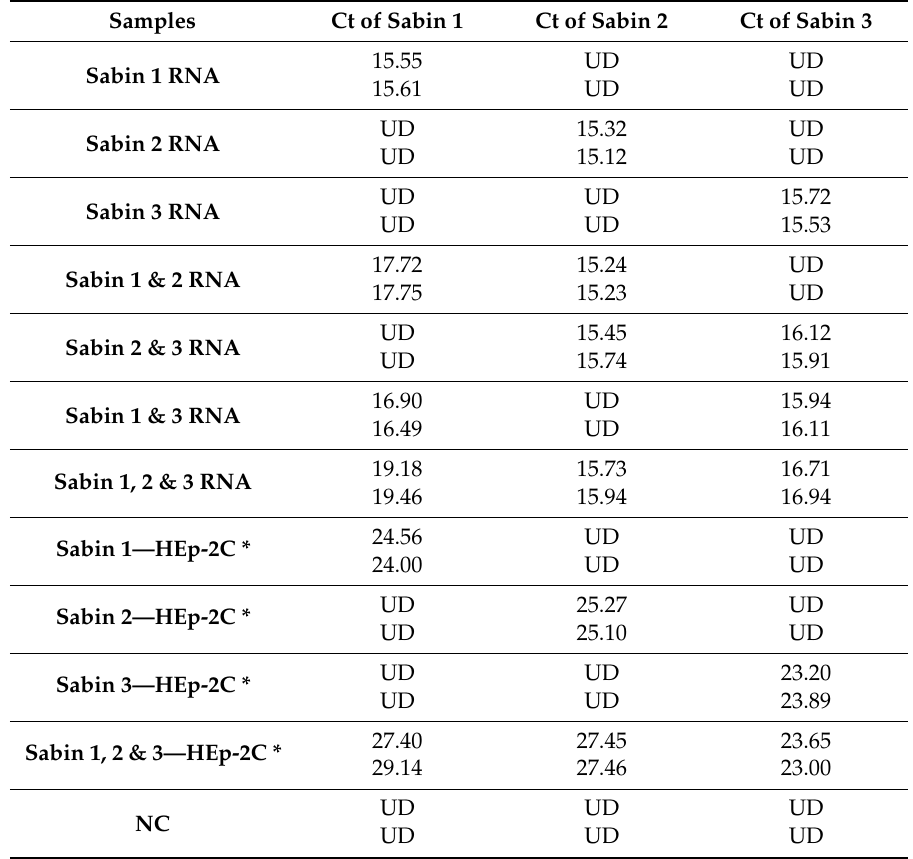
Table 1. qmosRT-PCR identification of Sabin strains in duplicates using di ff erent combinations of purified RNA and infected cell